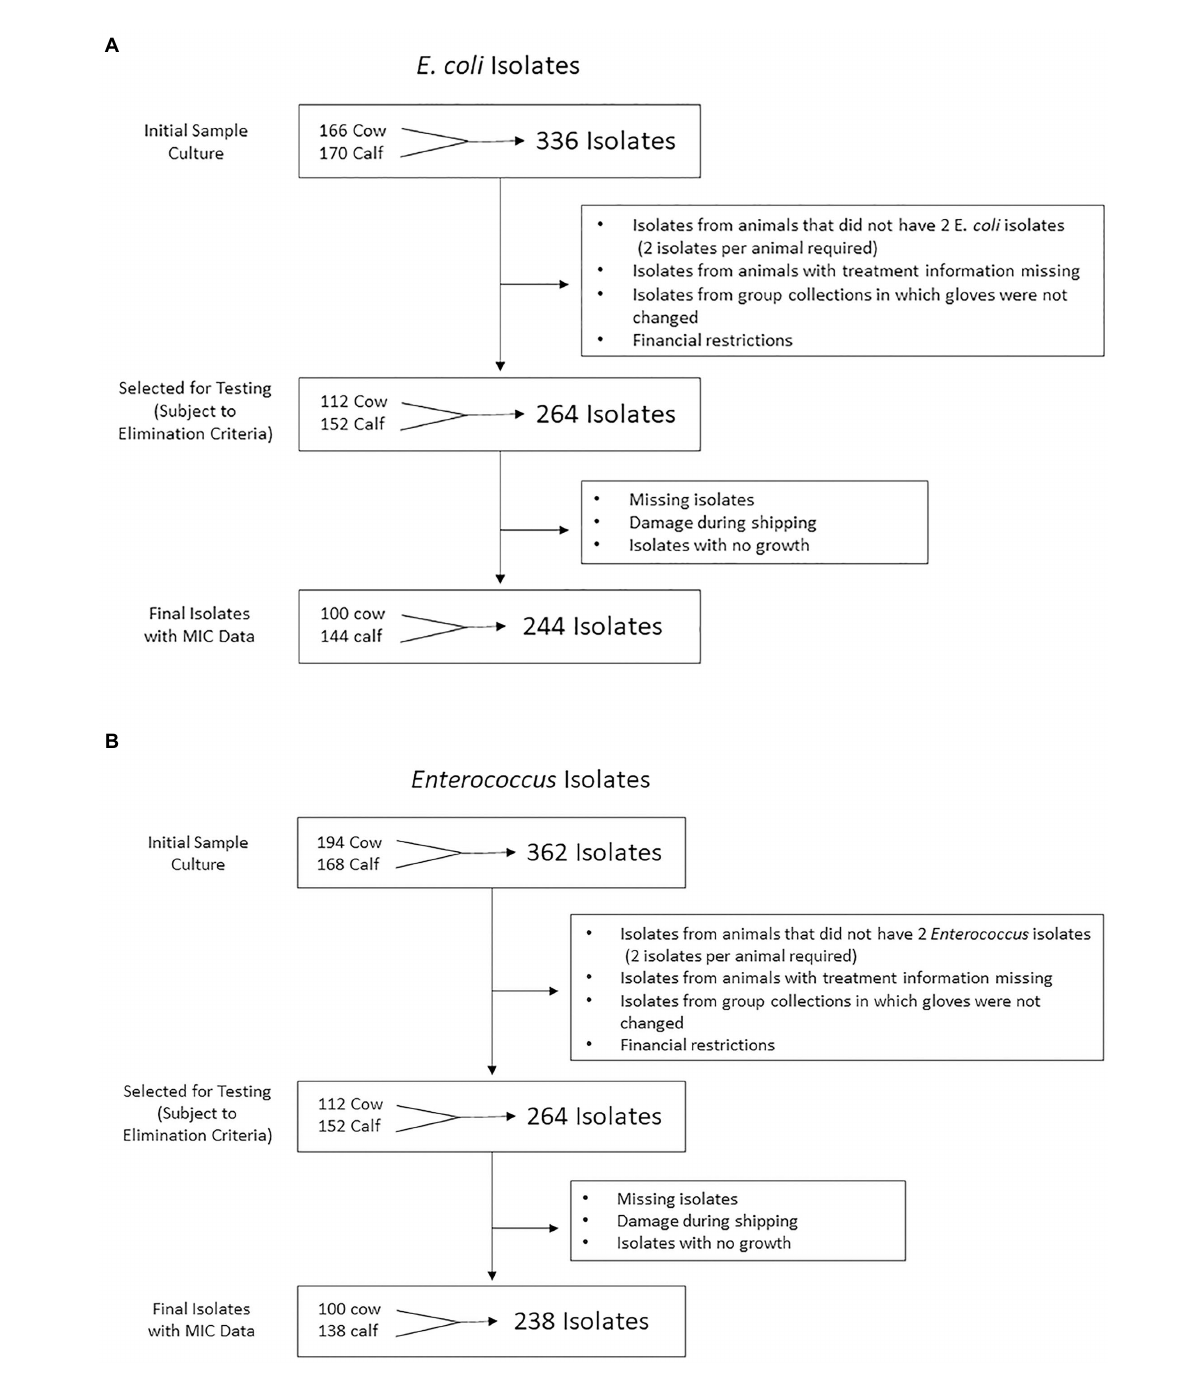
FIGURE 1 Flow chart representation of (A) Escherichia coli and (B) Enterococcus isolate numbers at each stage of the study from farm to antimicrobial susceptibility testing. 244 E. coli and 238 Enterococcus isolates were isolated from cow and calf fecal samples in a study on prevalence of antimicrobial resistance on cow-calf operations in northern California collected between July 2019 and August